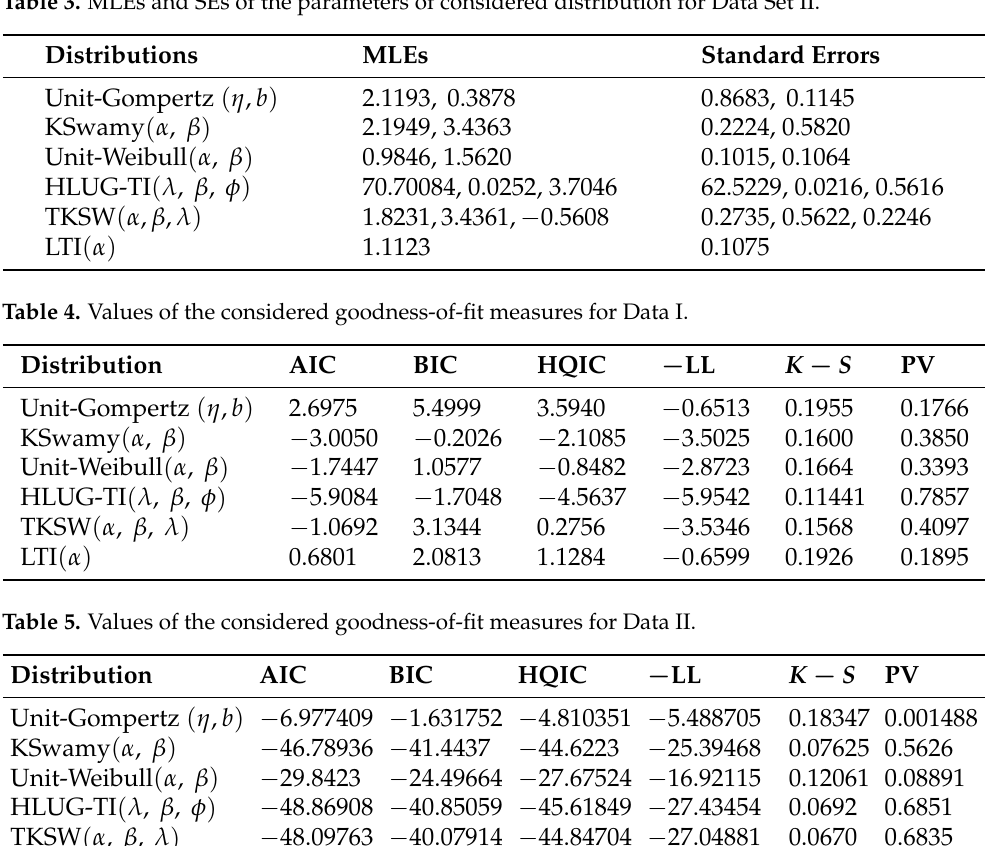
Table 3. MLEs and SEs of the parameters of considered distribution for Data Set II.